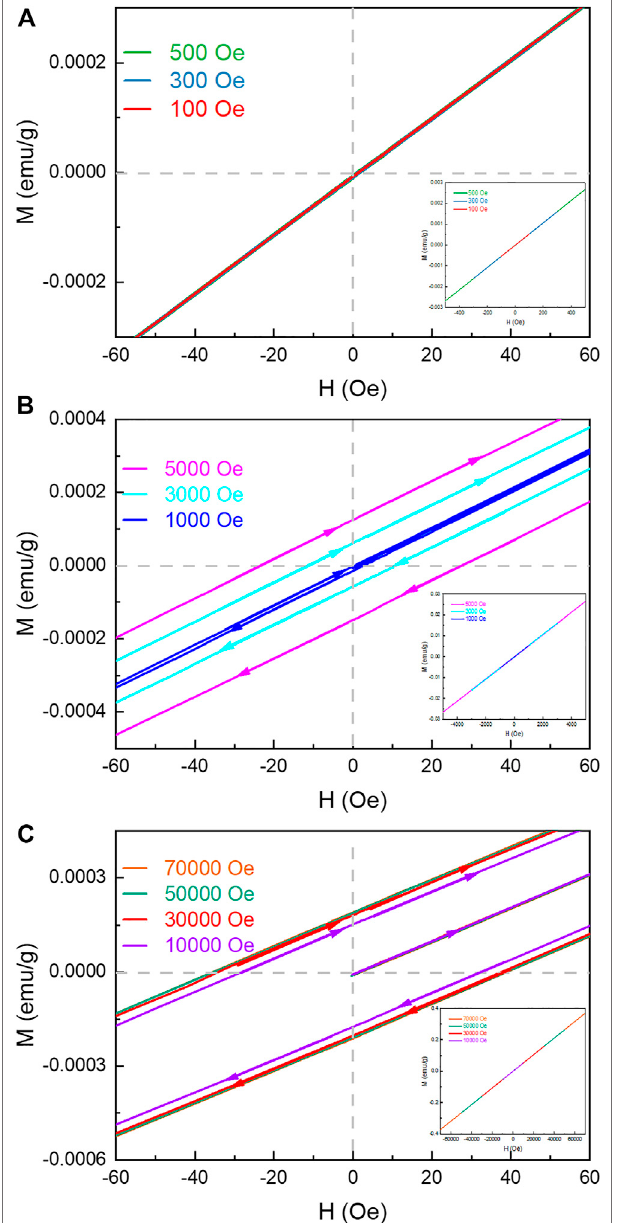
FIGURE 3 | M ( H ) loops enlarged near the origin for different scanning fi eld ranges ofstandard Pd sample at300 K. Thearrows stuck to thecurve denote the directionofthe fi eldsweep.Theinsetshowsthefullloopmeasuredincorresponding fi eld ranges. (A) At low scan fi elds, inverted hysteresis loop is absent for standard Pd sample. (B,C) M ( H ) loops for higher scan fi elds, the loop is inverted.